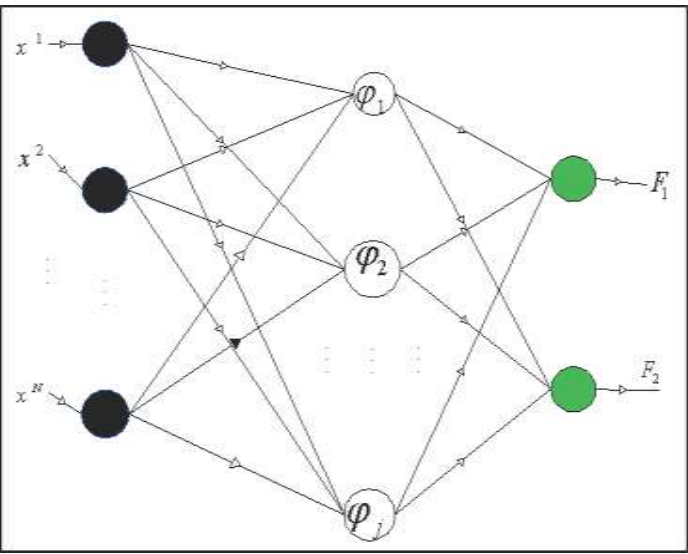
Figure 5. Structure of a radial basis function neural network.